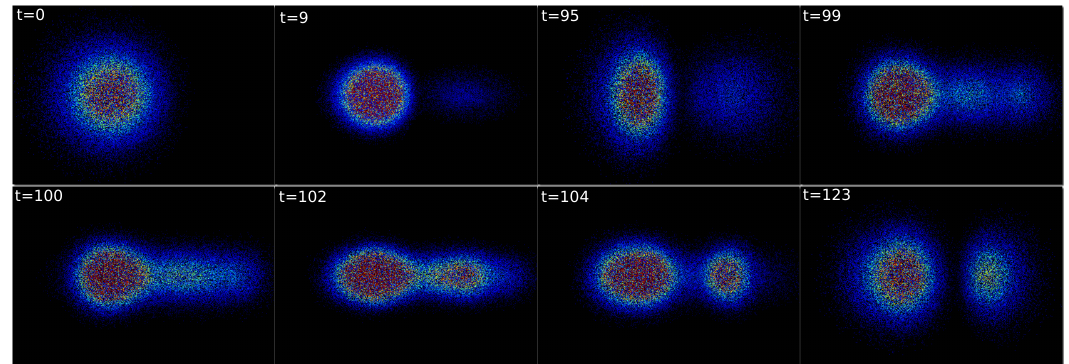
Figure 10. Illustration of the evolution of the wavefunction during a quantum tunneling process.